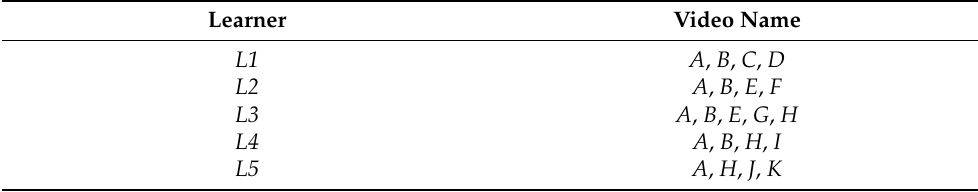
Table 2. Simplified video